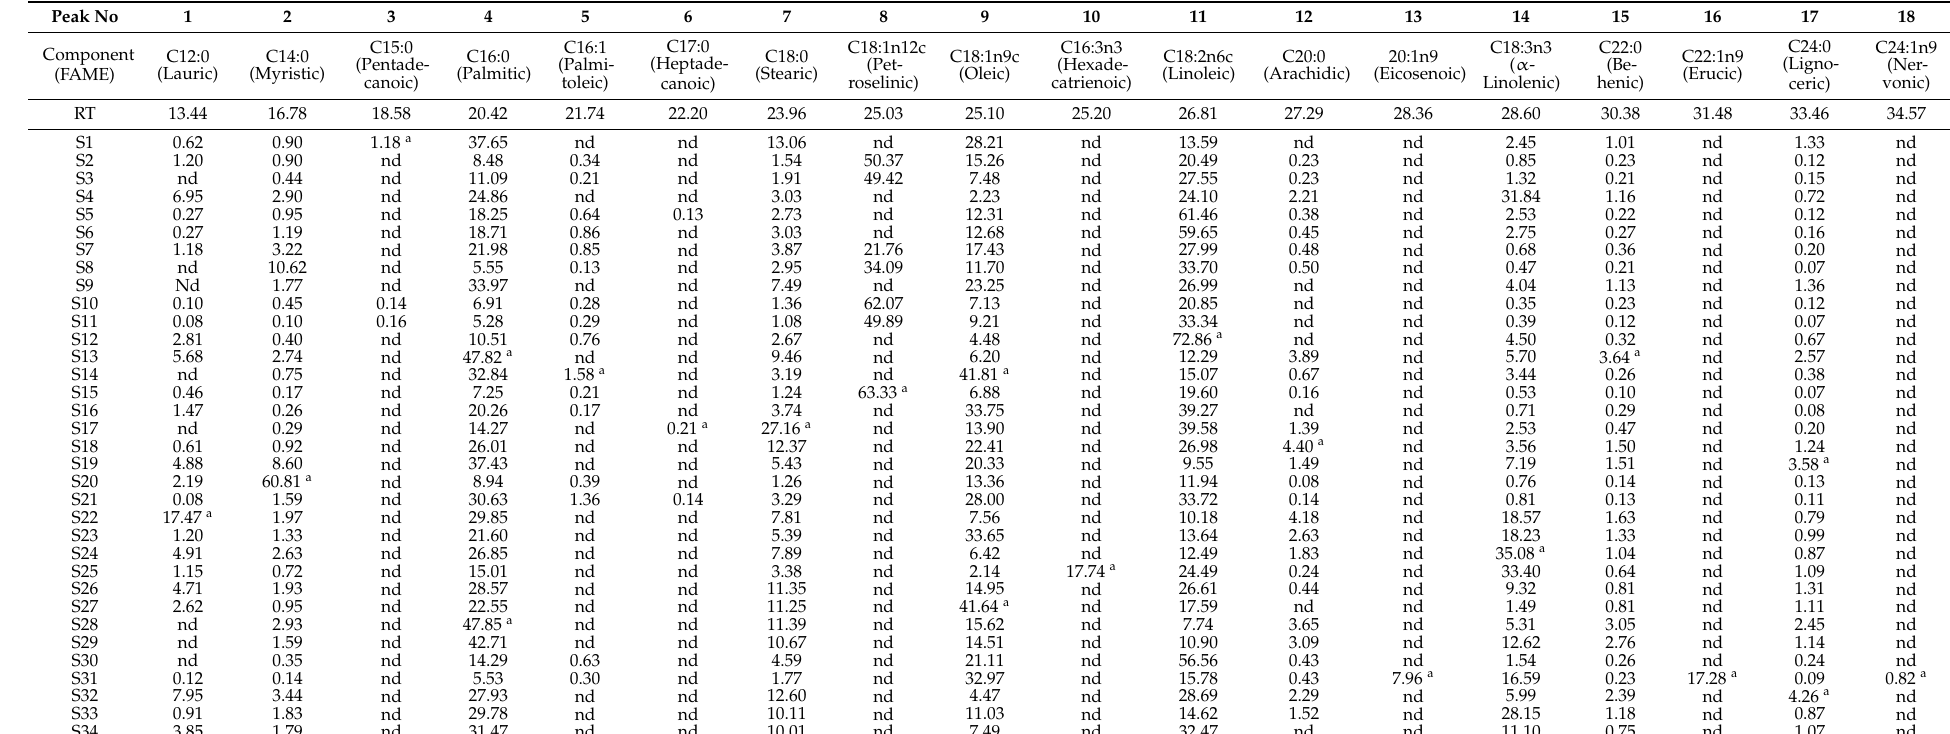
Table 2. Fatty acid composition of spices and